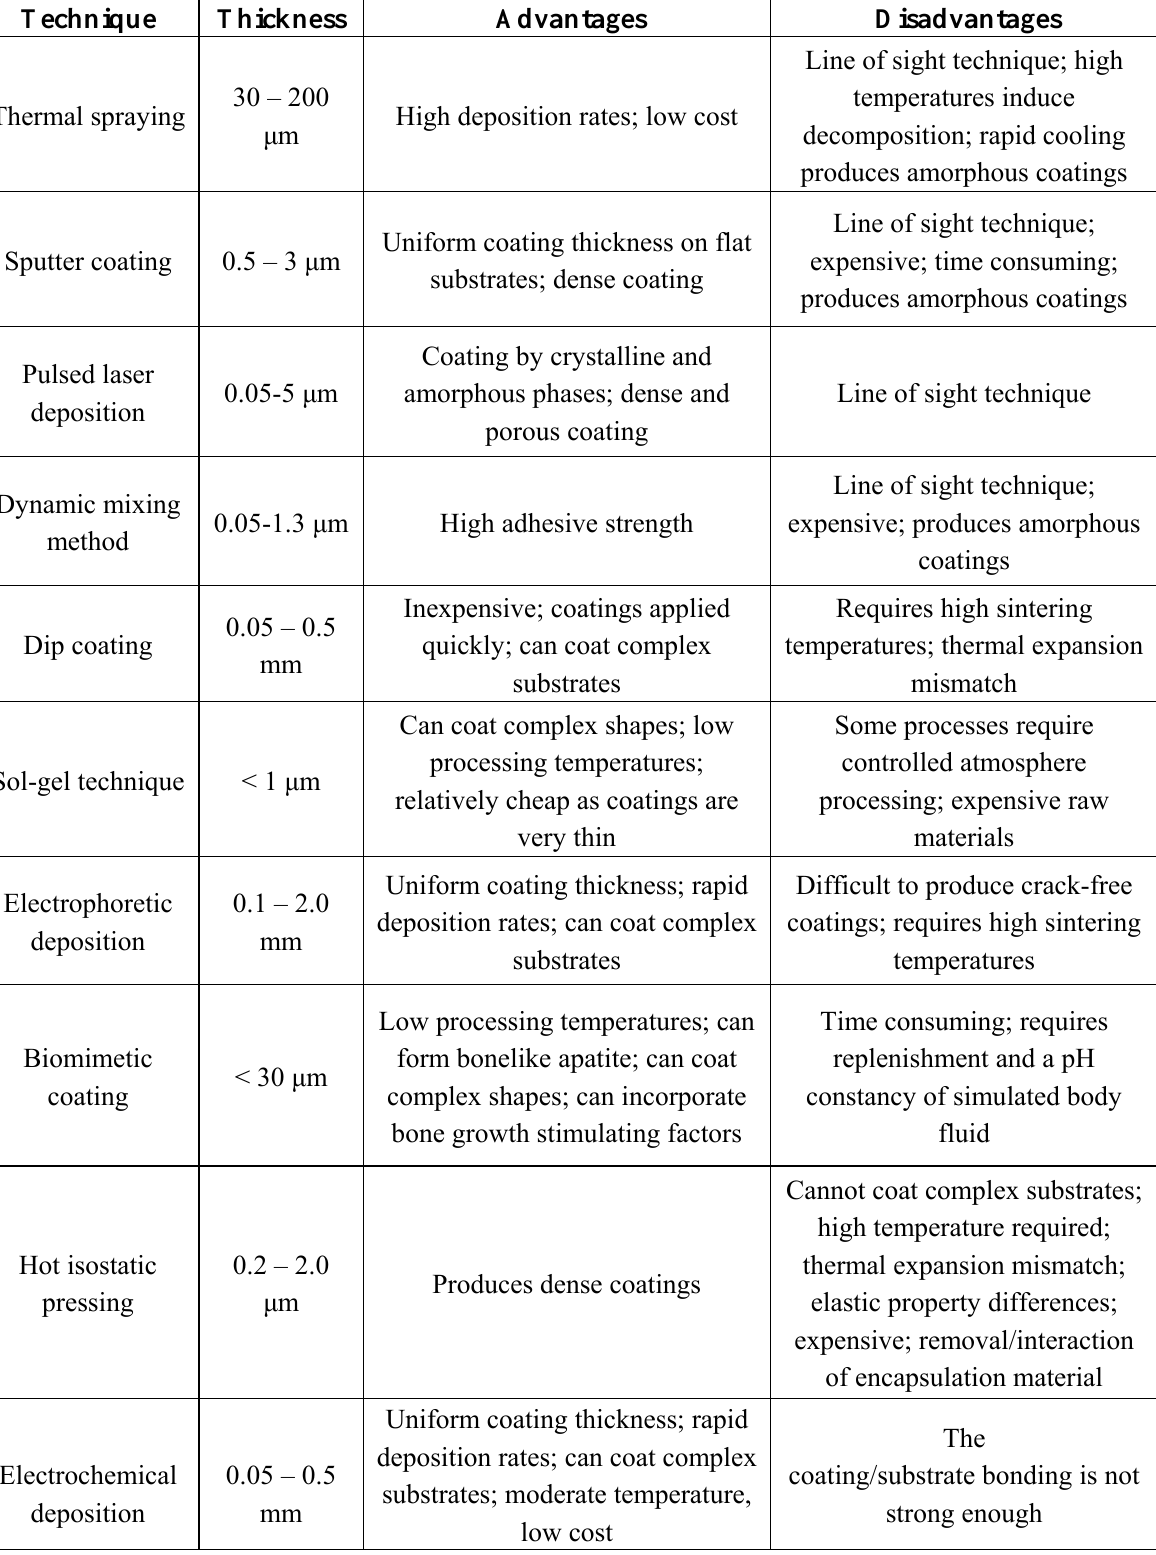
Table 5. Various techniques to deposit bioresorbable coatings of calcium orthophosphates on metal implants